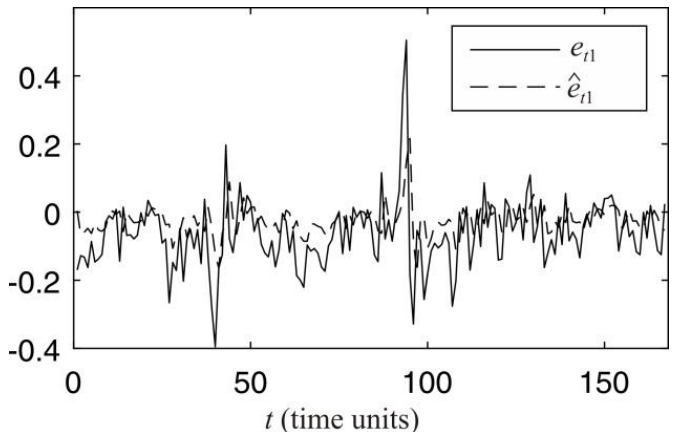
Figure 7. Prediction of the process e t , 1.